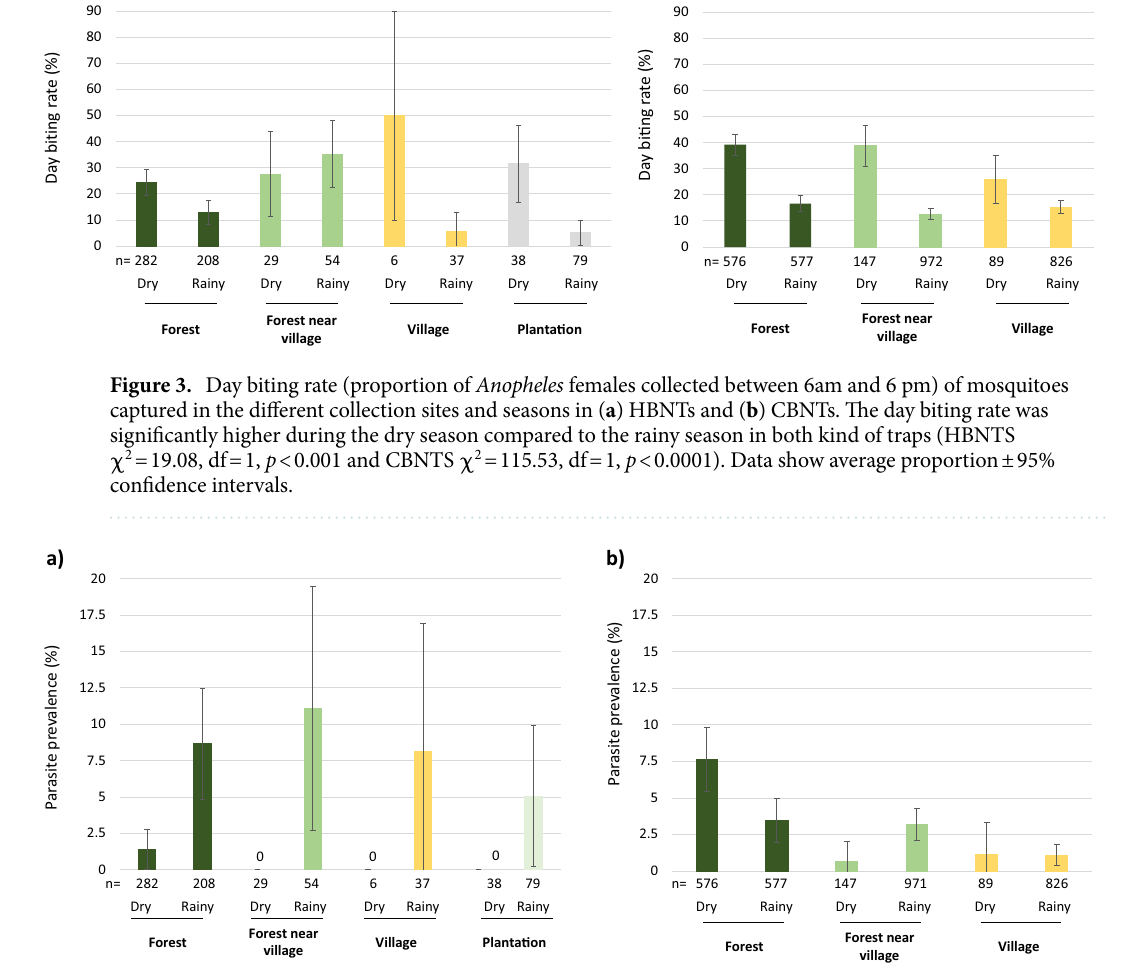
Figure 4. Malaria parasite prevalence in mosquitoes captured across different collection sites and seasons in ( a ) HBNTs and ( b ) CBNTs. Data show average proportion ± 95% confidence intervals. Numbers below the bars indicate the total number of mosquitoes. Zero in the graph indicates no infected mosquitoes. Malaria parasite prevalence was significantly higher during the dry season compared to the rainy season in the HBNTS ( χ 2 = 8.57, df = 1, p = 0.003) whereas the opposite was observed in the CBNTS ( χ 2 = 5.44, df = 1, p = 0.02). In the CBNTS, malaria parasite prevalence was significantly affected by daytime ( χ 2 = 8.13, df = 1, p = 0.004) and the interaction between collection sites and seasons ( χ 2 = 6.94, df = 2, p = Malaria infection rates. Samples were screened to detect Plasmodium sp . in the head and thorax, thus indicating mosquitoes likely to be infectious due to carriage of sporozoites in the salivary glands (Fig. 4). Over the 3919 mosquitoes tested, 141 positive samples were found (3.6%; 122 P. vivax , 13 P. falciparum , 4 mixed P. falciparum and P. vivax , 1 mixed P. falciparum and P. vivax and P. ovale , 1 mixed P. falciparum and P. inui ). In addition, 2 mosquitoes were found infected by P. cynomologi and 3 by P. inui , these non-human malaria parasites were not included in the following analyses. Malaria infection rate in HBNTs (4.77 ± 1.5%) was not significantly higher than in CBNTs (3.33 ± 0.62%; χ 2 = 3.19, df = 1, p = 0.07). In the HBNTs, malaria infection rate was sig- nificantly higher during the rainy season (8.2 ± 2.8%) compared to the dry season (1.13 ± 1.1%; χ 2 = 8.57, df = 1, p = 0.003; Odds Ratio = 5.04 [1.53–16.53]). Plasmodium sp . prevalence was not significantly correlated with col- lection site ( χ 2 = 1.89, df = 3, p = 0.60), nor with time of sampling ( χ 2 = 0.22, df = 1, p = 0.64). In the CBNTs, the prevalence of Plasmodium -positive mosquitoes was significantly higher during the dry season (5.66 ± 1.6%) compared to the rainy season (2.53 ± 0.6%; χ 2 = 5.45, df = 1, p = 0.02). Malaria infection rate was not significantly different across collection sites ( χ 2 = 5.87, df = 2, p = 0.053), although more infectious mos- quitoes were collected in the forests (5.55 ± 1.32%) compared to the forest near the villages (2.86 ± 1%) and the villages (1.1 ± 0.7%). Malaria infection rate was higher in mosquitoes collected during daytime (6 ± 1.8%) com- pared to night time (2.64 ± 0.6%; χ 2 = 8.13, df = 1, p = 0.004) regardless of the collection sites (daytime: collection site interaction: χ 2 = 3.28, df = 2, p = 0.19). Malaria infection rate was significantly influenced by the interaction between collection sites and seasons ( χ 2 = 6.89, df = 2, p = 0.03) with opposite patterns in the malaria infection